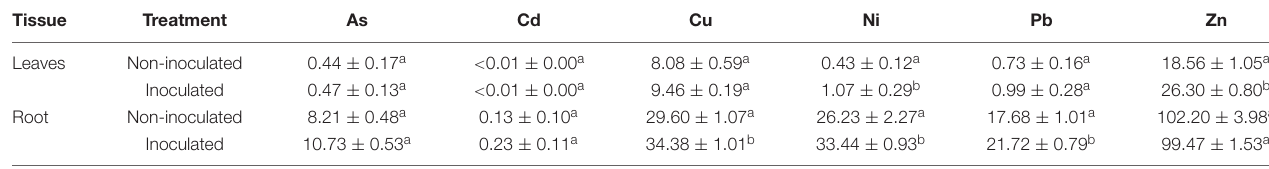
Values are means ± S.E. Different letters indicate statistical differences for each metal(loid) and tissue between bioaugmentation treatments. TABLE 6 | Distribution of arsenic (As), cadmium (Cd), copper (Cu), nickel (Ni), lead (Pb), and zinc (Zn) in estuarine soils of our study and S. ramosissima in natural conditions (non-inoculated). Odiel vs. Piedras As